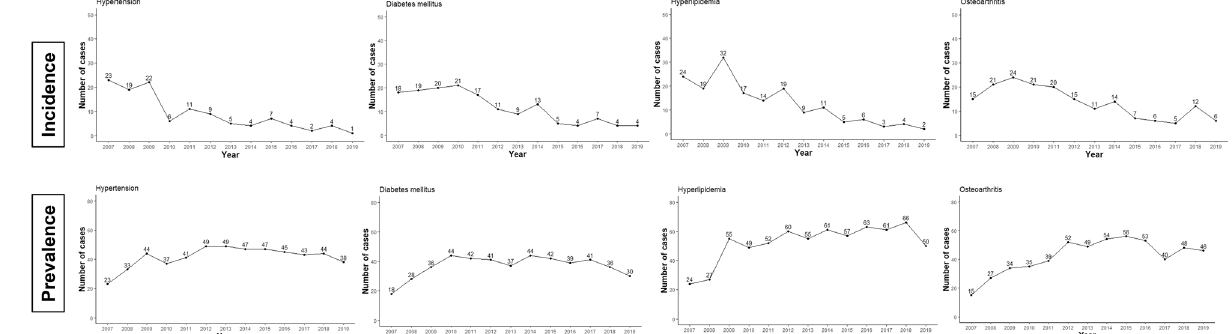
Figure 3. The occurrence patterns of comorbidities during the follow-up period. The incidence and prevalence of newly developed comorbidities were presented as the number of new patients in the year and total number of patients in the year,